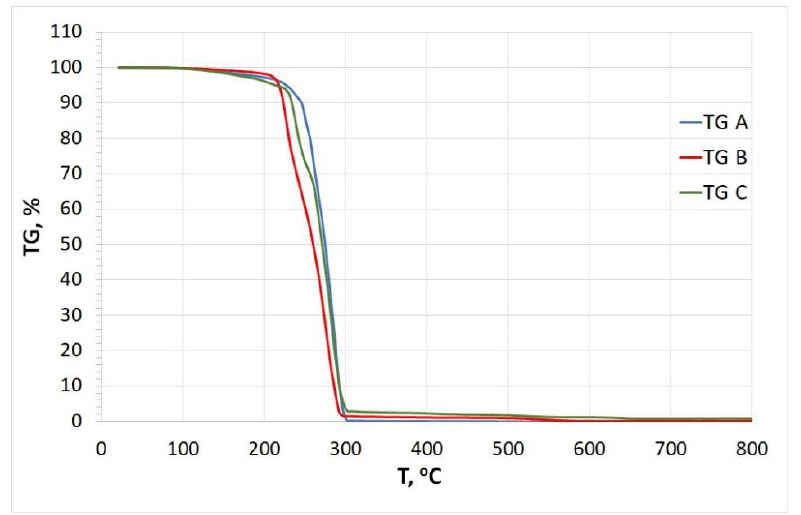
Figure 6. TG results of explosives containing microstructure charcoal grains of −1.18 mm, sample 2 (TG A), sample 3 (TG B), sample 4 (TG C).